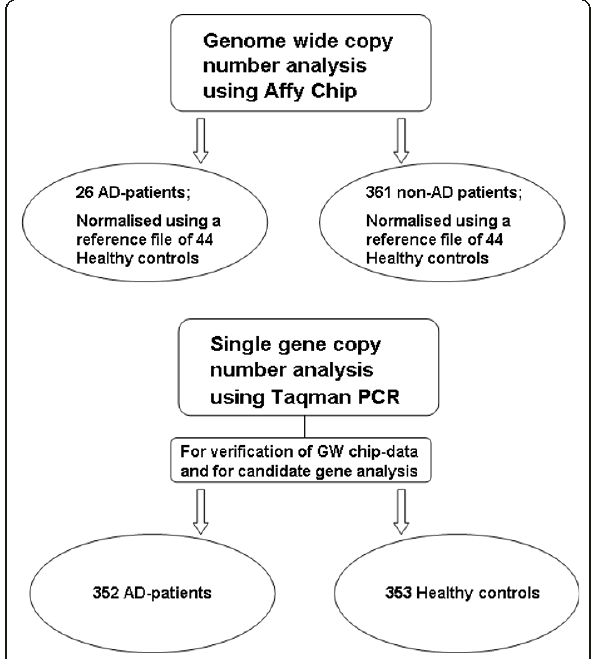
Figure 1 Flow chart of the methods and subjects used in the present study